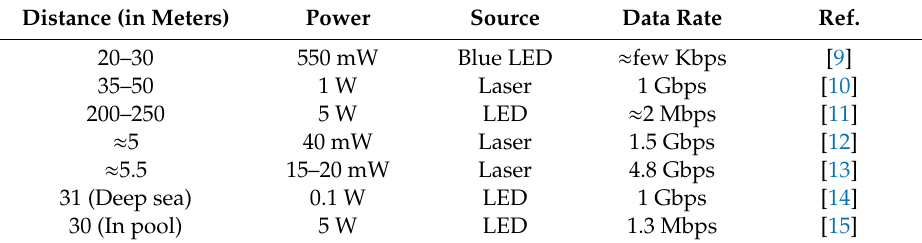
Table 2. Di ff erent optical tracking sources used for underwater communication